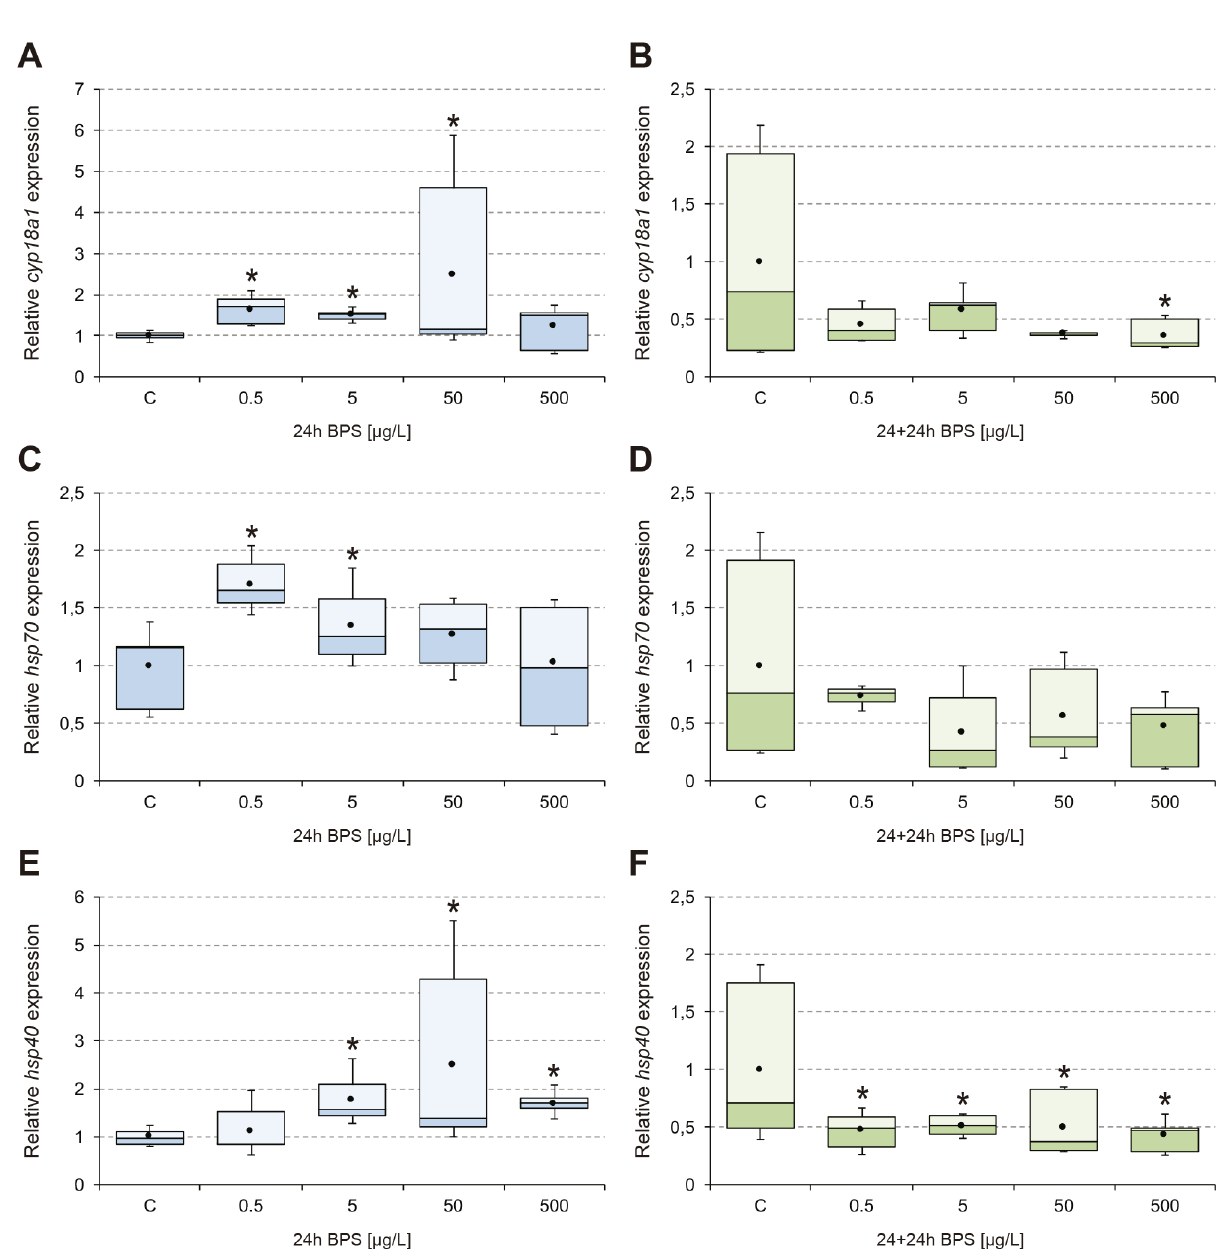
Fig 2. Transcriptional activity of cyp18a1 , hsp70 ,and hsp40 . Box-and-whisker plots represent the expression patterns of cyp18a1 (A-B), hsp70 (C-D), and hsp40 (E-F), measured by real-time RT-PCR. C . riparius fourth instar larvae were exposed to 0.5–500 μg/L BPS for 24 h (24h; left column; blue series), and maintained for an additional 24 h in fresh culture medium after BPS withdrawal (24+24h; right column; green series). Four independent experiments were performed and RNA was extracted from 5 larvae for each experimental condition (n = 20). Results were normalized to control values. Box and whiskers represent the 25–75 percentile and the minimum/maximum measured values; the mean is represented by a dot; the horizontal line separating the lower (dark) and the upper (light) area represents the median. Asterisks ( (cid:3) ) indicate significant differences (p (cid:20) 0.05) with respect to control